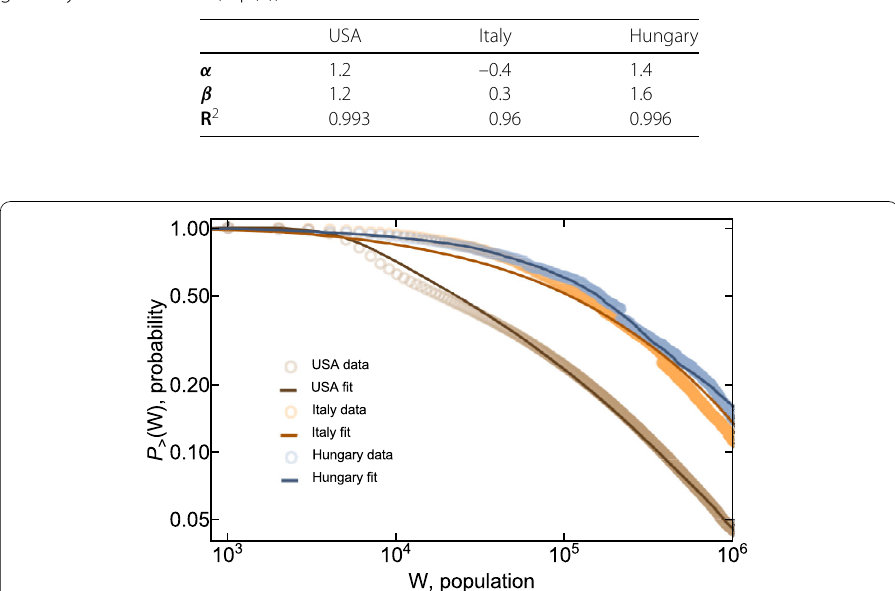
Figure 7 Visual comparison between the GM model prediction and experimental data for three countries (USA, Italy, Hungary). The faint lines composed of circles show the P > ( W ) experimental data and the simple dark colored lines are the best fits with the GM model prediction (Eq. (3)). The best fit parameters are given in Table